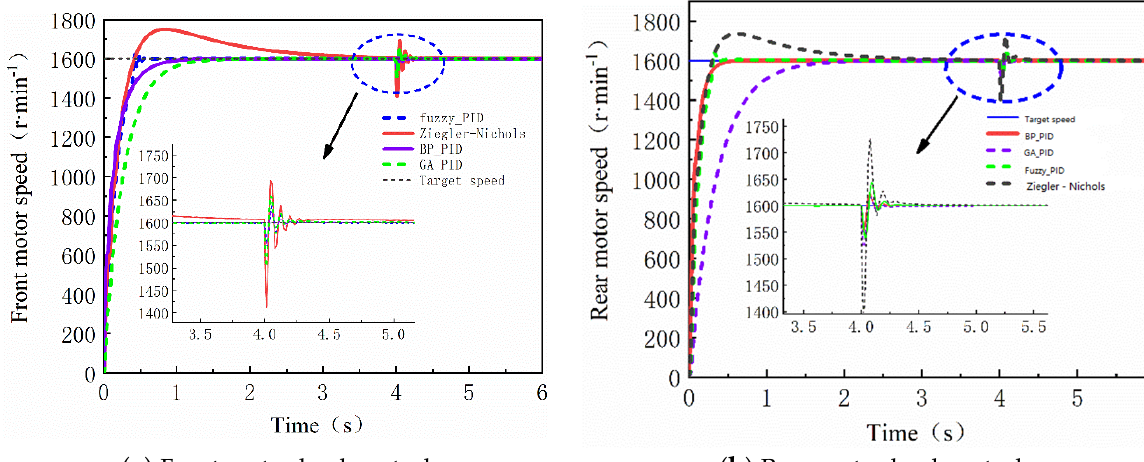
Figure 19. system constant speed load control. Figure 19. System constant speed load control.